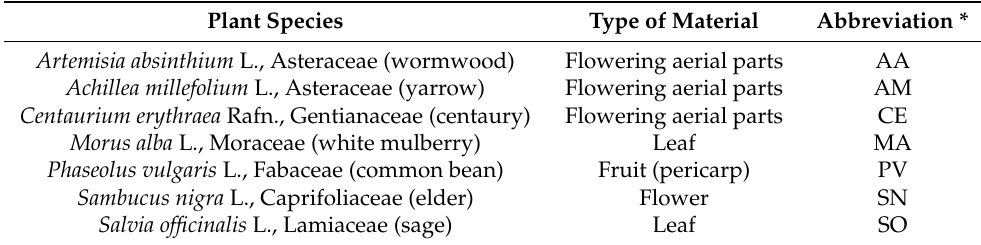
Table 2. The medicinal plants, extracts, and their abbreviations used in this study.